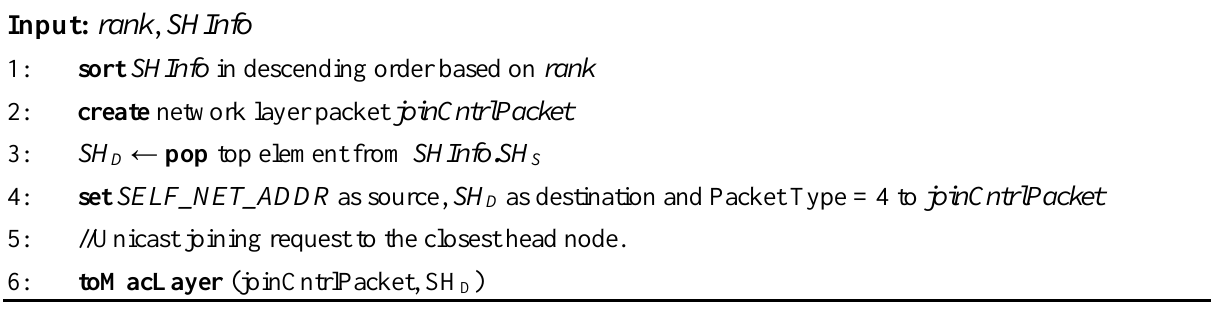
Algorithm 3. Head_Selection (), implemented in member nodes, selects the closest SH based on the rank calculated using Equation